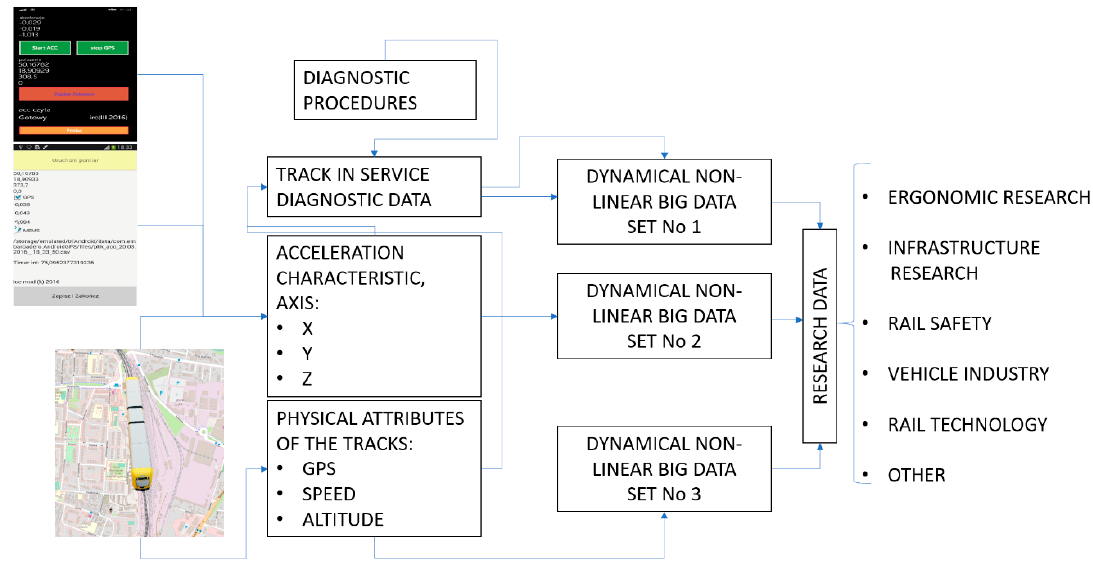
Figure 14. Research methodology scheme: Source: authors’ own materials.